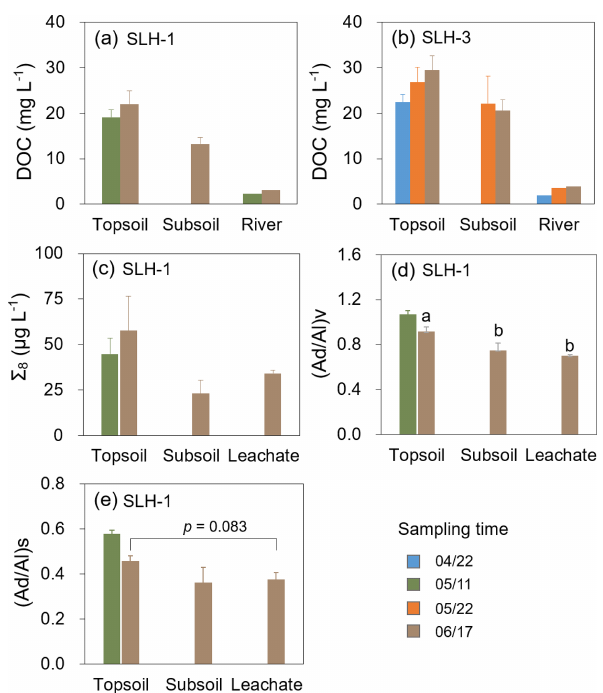
Figure 5. Variations in dissolved organic carbon (DOC) in soil so- lutions and river water at SLH-1 (a) and SLH-3 (b) stations. Ab- solute concentration of lignin phenols ( (cid:54) 8 ) in soil solutions and leachates at SLH-1 station (c) , and the variations in the acid-to- aldehyde (Ad / Al) ratios of syringyl (S) and vanillyl (V) phenols in soil solutions and leachates at SLH-1 station (d–e) during the thawing period in 2018. Error bars in panels (a–e) represent the standard error of the mean ( n = 4). Lowercase letters in panel (d) indicate different levels of Ad / Al ratio among the leachates, topsoil and subsoil solutions (one-way ANOVA, n = 4, p < 0.05) while p values in panel (e) indicate the marginal difference of the Ad / Al ratio between topsoil solutions and